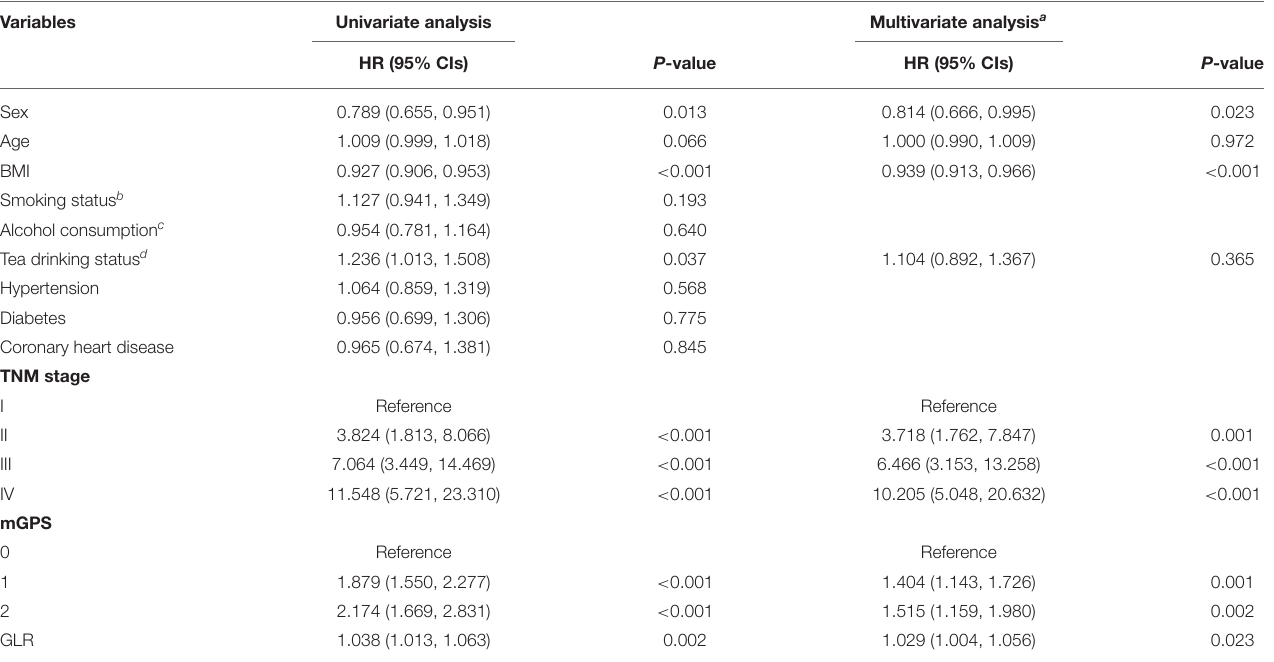
TABLE 2 | Associations between clinical variables and OS in patients with